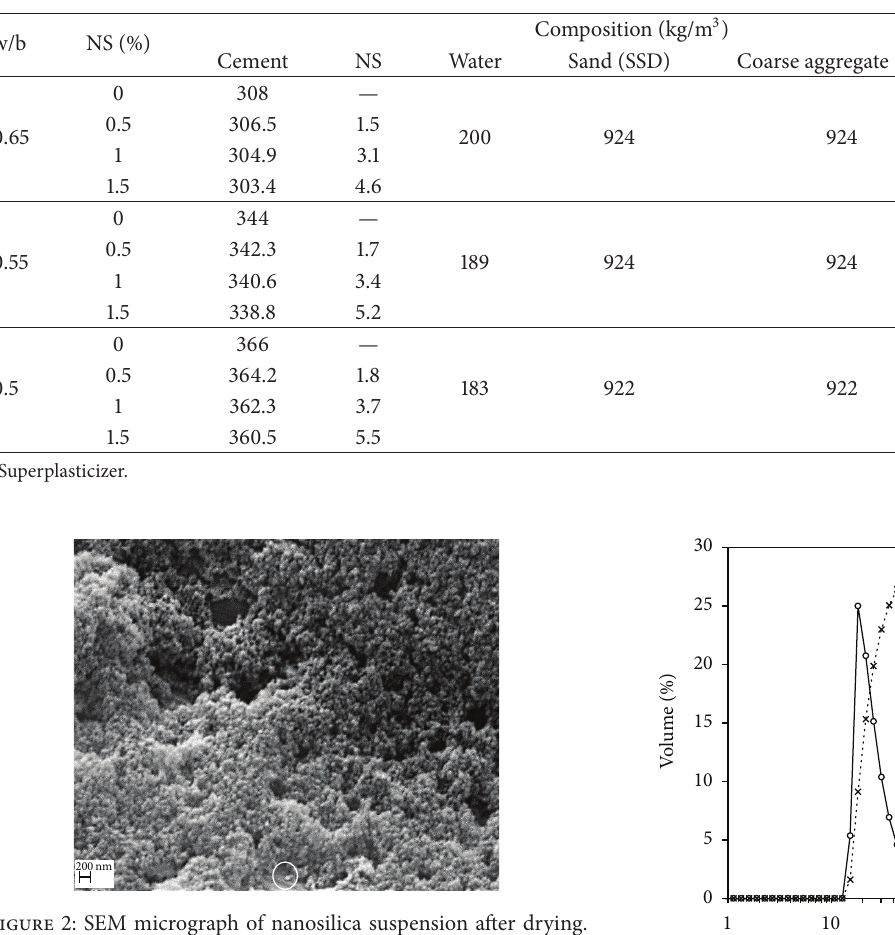
Table 2: Composition of concrete mixtures and slump values.